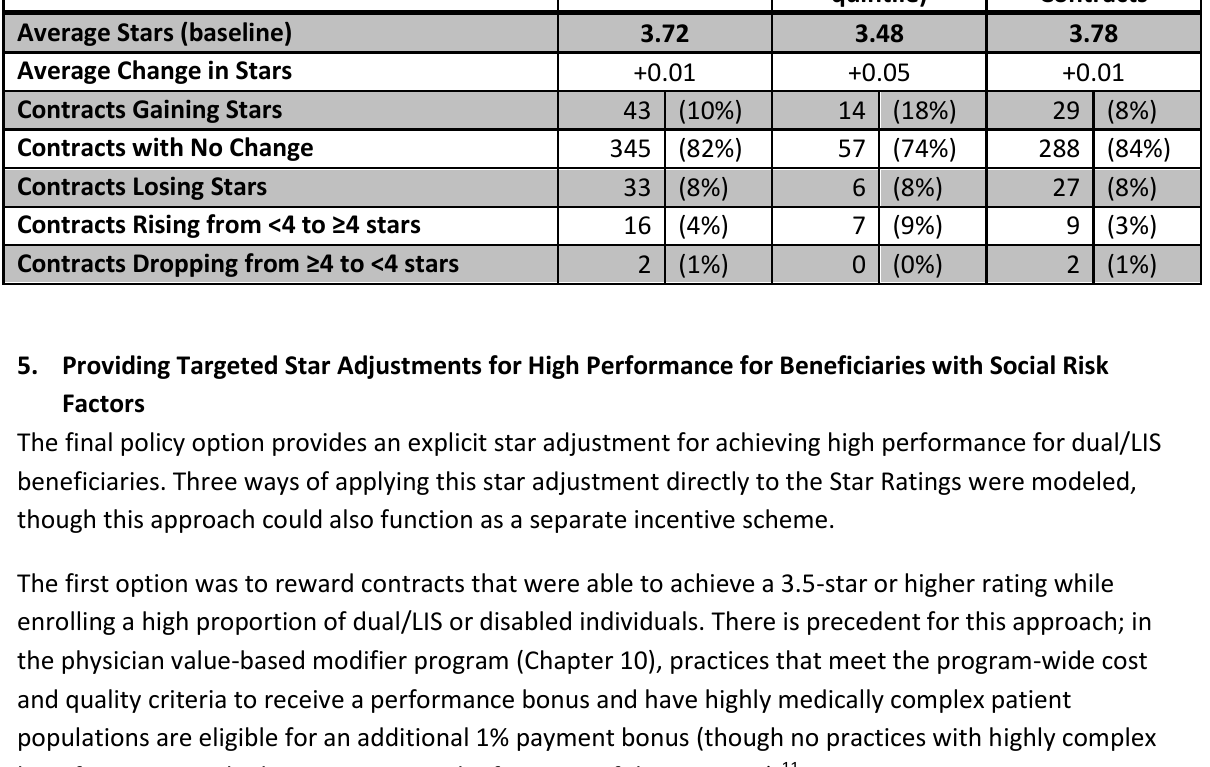
All Contracts High-Dual/LIS Contracts (top quintile)